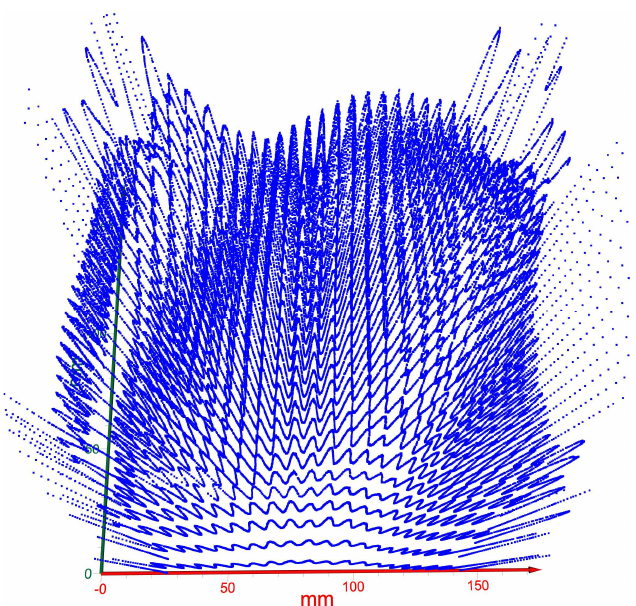
Figure 8. Scanned profile map created from profiles along a line on a row of dies for the entire wafer.